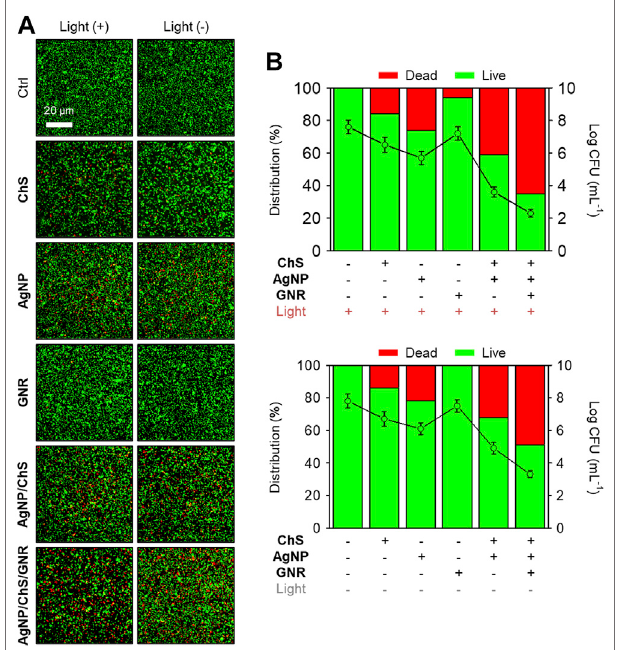
FIGURE 3 | (A) Fluorescence imaging and (B) quanti fi cation of the bio fi lm formed by Pseudomonas aeruginosa (ATCC 27853, 10 6 CFU ml − 1 ) before and after treatment with ChS (2 mg ml − 1 ), AgNP (10 μ g ml − 1 ),